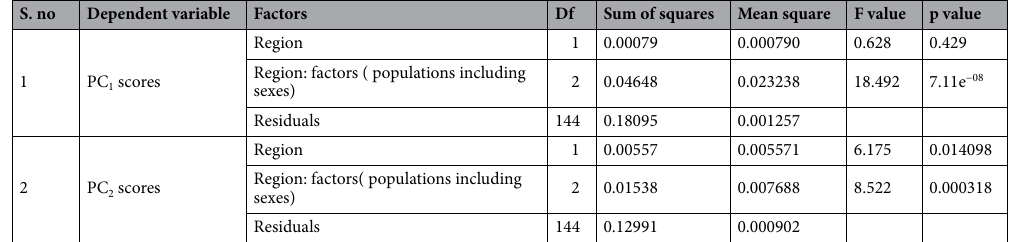
Table 2. The principal component scores as the dependent variables, while the regions (north and south) and sexes from both populations (coded as NM, NF, SM & SF) as factors in the nested-ANOVA. The population representing sexes is nested within the region.